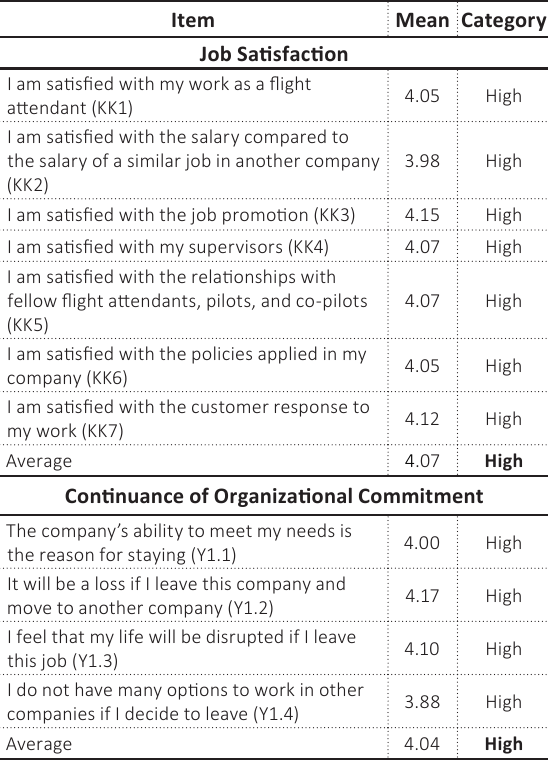
Table 1. Characteristics of respondents Characteristics